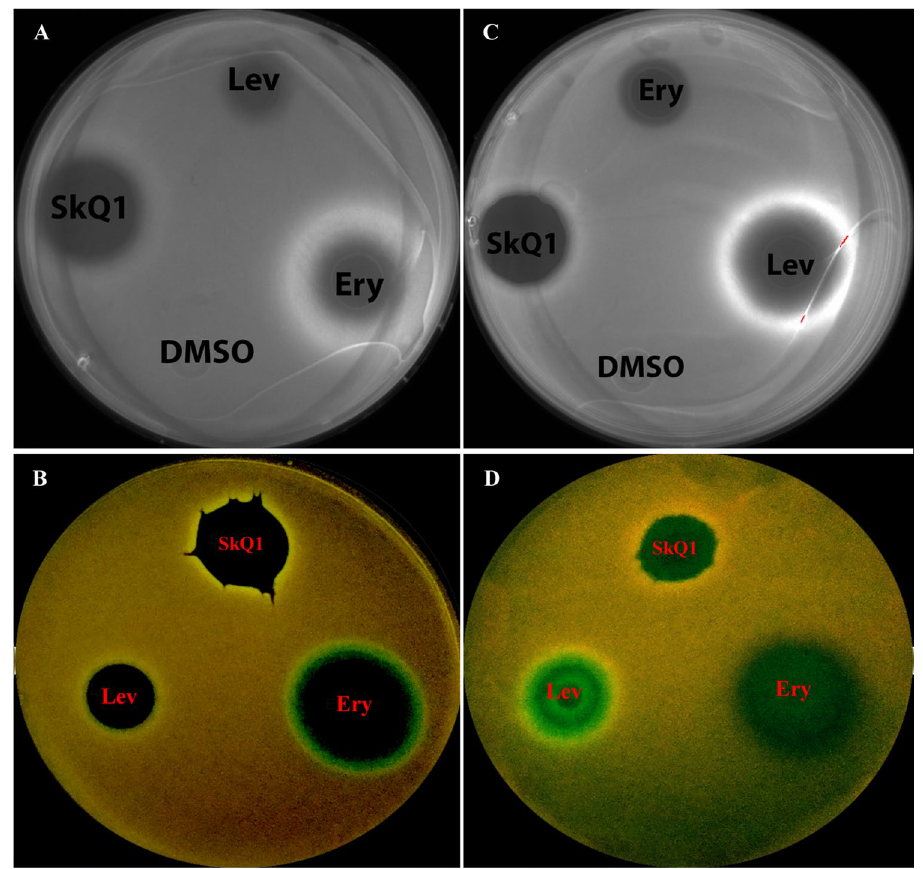
Figure 6. Induction of the translation inhibittion fluorescent reporter (left) or DNA damage fluorescent reporter (right) by SkQ1 on Petri plates. E. coli Δ tolC transformed with pRFPCER-TrpL2A (left) or pRFPCER- sulA (right) exhibited red fluorescence owing to RFP expression. SkQ1; erythromycin (ery) and levofloxacin (lev) were spotted on agar. Rings of cerulean fluorescence (cyan-green) were formed under the influence of the antibiotic causing ribosome stalling (left panel), and under the influence of the DNA-damaging antibiotic (right panel). Petri dishes were illuminated at UV (254-nm) and photographed by a digital camera (bottom panels) while the signal of cerulean protein fluorescence was detected in Cy2 channel by means of ChemiDoc (top